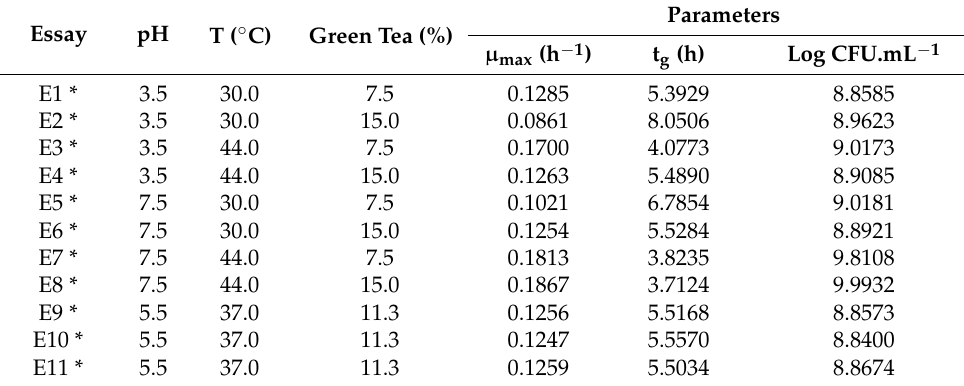
Table 3. Biological characteristics of L. gasseri in the fermentation of passion fruit juice added with green